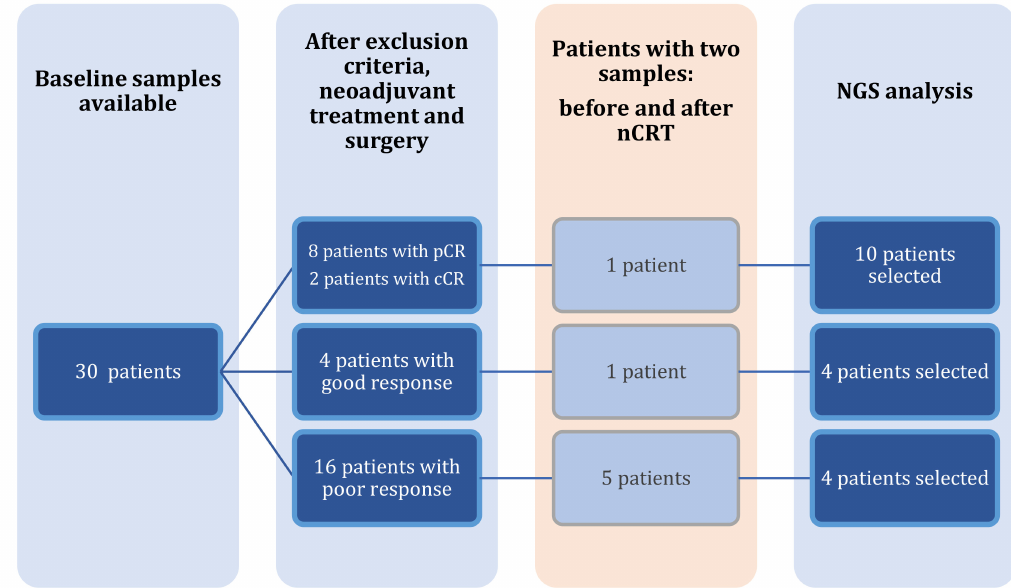
Figure 1. Study flowchart of selection of patients for NGS analysis.